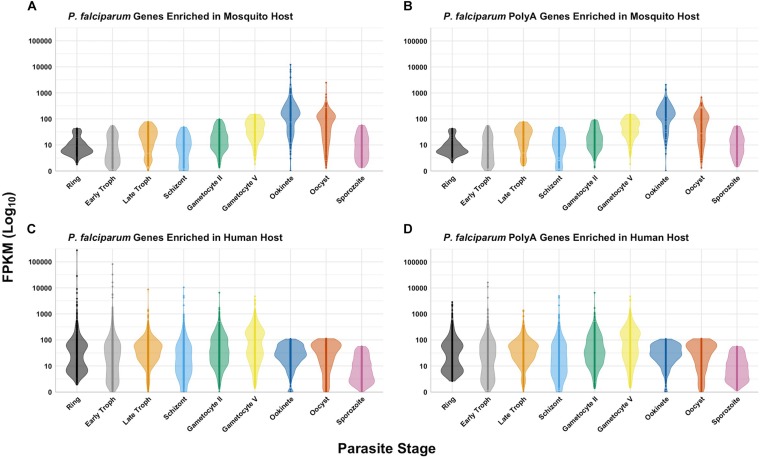
Expression of P. falciparum genes in different hosts. The data was queried from PlasmoDB (Aurrecoechea et al., 2009; López-Barragán et al., 2011; Zanghì et al., 2018) for protein-coding genes with expression data greater than or equal to the 80th percentile for ring, early trophozoite, late trophozoite, schizont, gametocyte II, gametocyte V, ookinete, oocyst, and sporozoite stages. P. falciparum genes enriched in the mosquito host (A), human host (C), and polyA genes for each (B and D, respectively) are as previously defined. RNAseq data for all stages in both hosts for these gene sets are displayed in log scale as a violin plot with all data points for comparison.